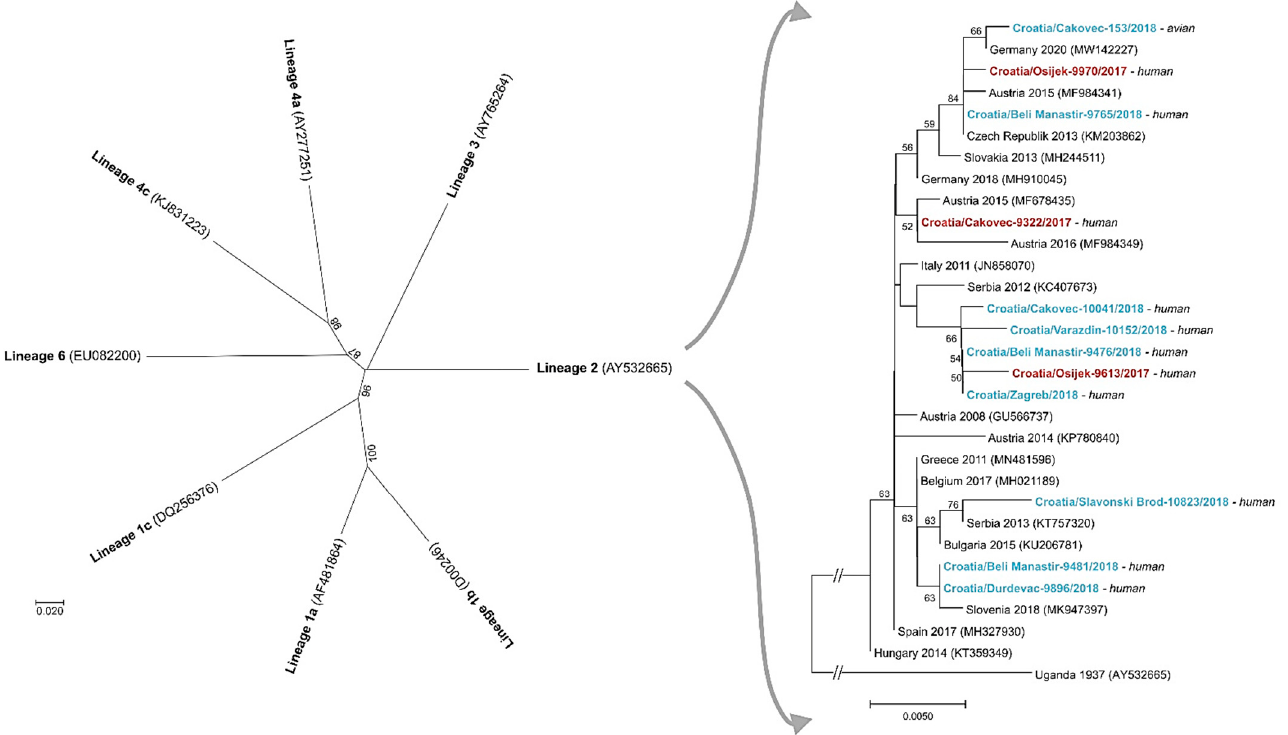
Figure 7. The rectangular phylogenetic tree displays genetic diversity of selected West Nile virus (WNV) isolates from Croatia, which belong to WNV lineage 2, as shown in the radial phylogenetic tree. The evolutionary history was inferred on 848 positions of the NS5 gene using the Neighbor-Joining method. Both trees are rooted with the first WNV strain (strain B956, Uganda 1937). Supporting ( ≥ 50%) bootstrap values of 1000 replicates are displayed at the nodes. Scale bars indicate nucleotide substitutions per site. The interrupted branches, indicated by double slashes, were shortened by 50% for better graphic representation. WNV isolates from Croatia are marked in bold and with hosts indicated next to the taxa. The Croatian isolates from 2017 are in red and isolates from 2018 in blue color. The other taxa are indicated by GenBank accession numbers as well as with the country of origin and isolation/detection year for those in the rectangular phylogenetic tree. The WNV lineages in the radial tree are proposed by Rizzoli et al. [22].